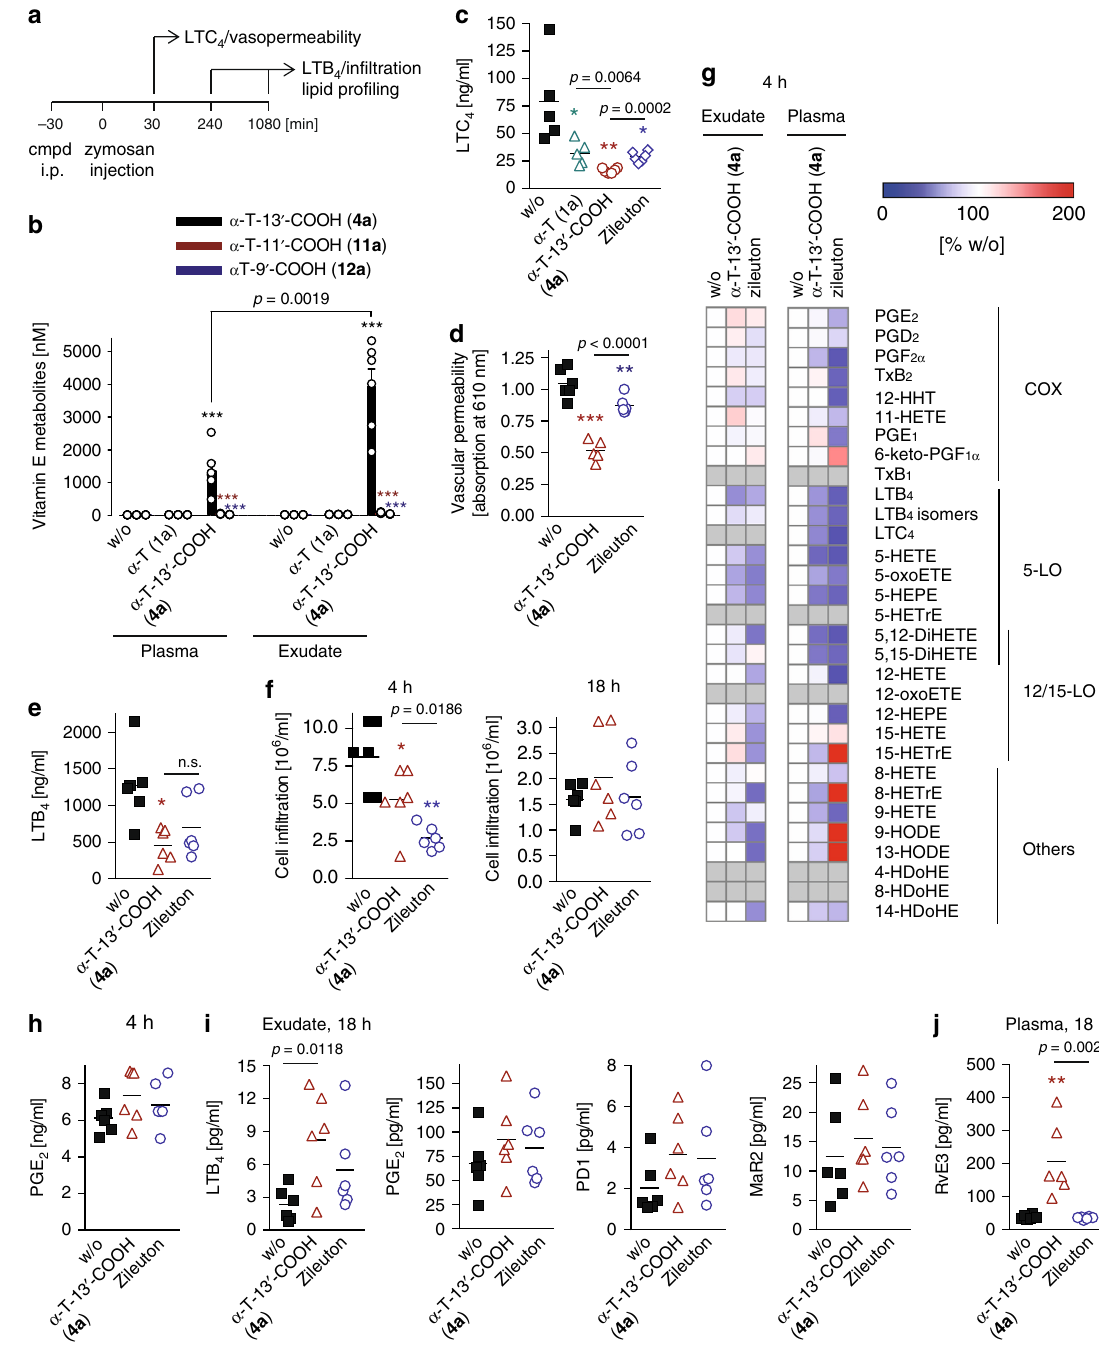
Fig. 5 α -T-13 ′ -COOH ( 4a ) inhibits 5-LO product formation in vivo along with reduced in fl ammation in murine peritonitis. a Time-scale for zymosan- induced murine peritonitis. Cmpd, compounds. b – j Vehicle (DMSO), α -T ( 1a ), α -T-13 ′ -COOH ( 4a ) or zileuton (10 mg/kg, i.p., each) were administered